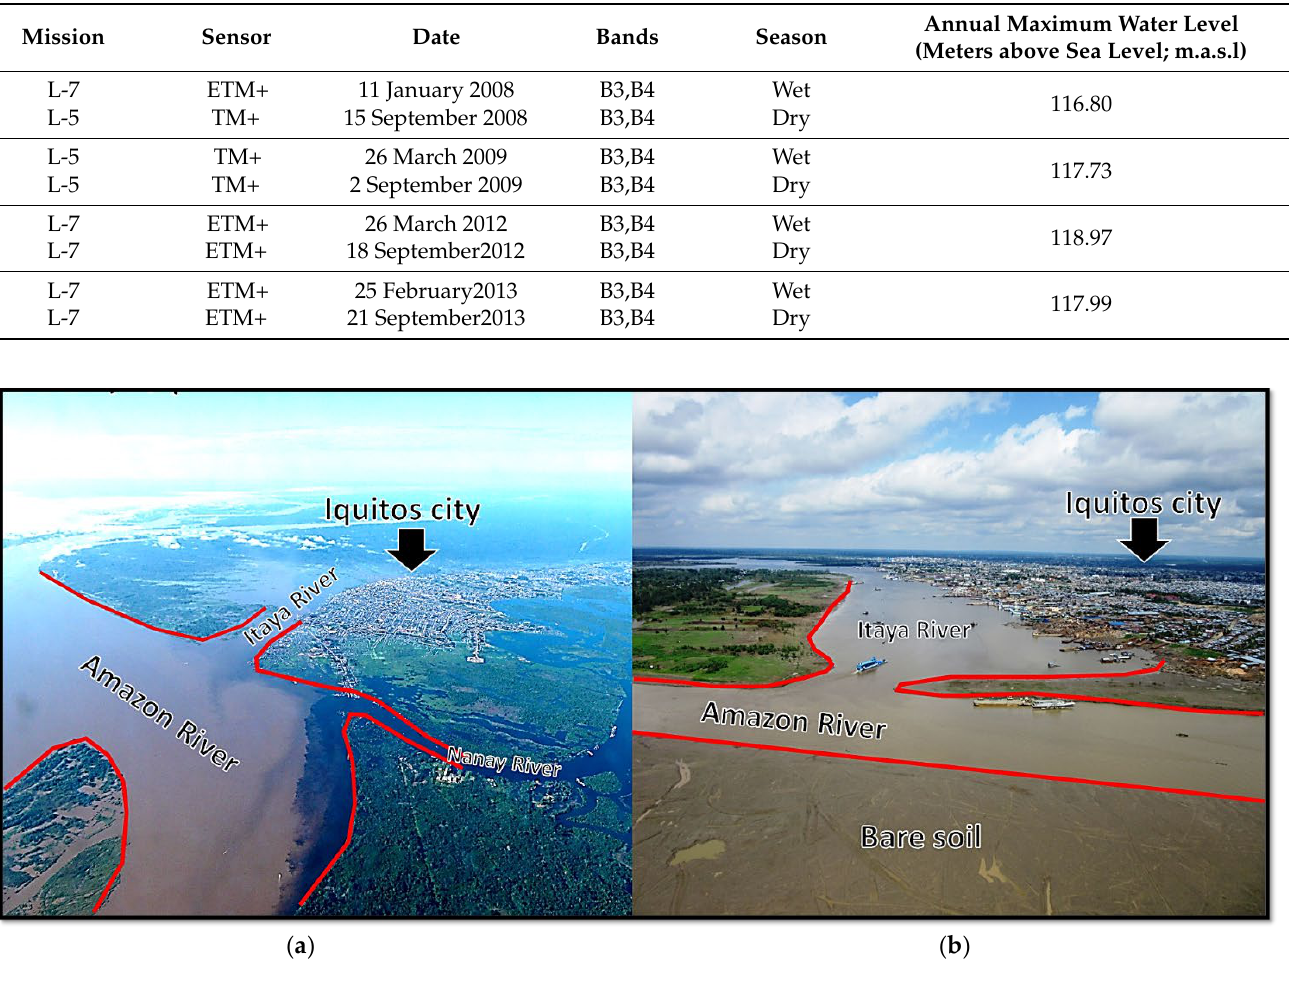
Figure 4. Aerial photos taken in the ( a ) wet season and ( b ) dry season in the Amazon reach (from the Service of Hydrography and Navigation of the Amazon; SHNA). The red line shows the channel of the river. The channel is wide in the wet season and narrow in the dry season because of the water level and the sediment deposition as bare soil.